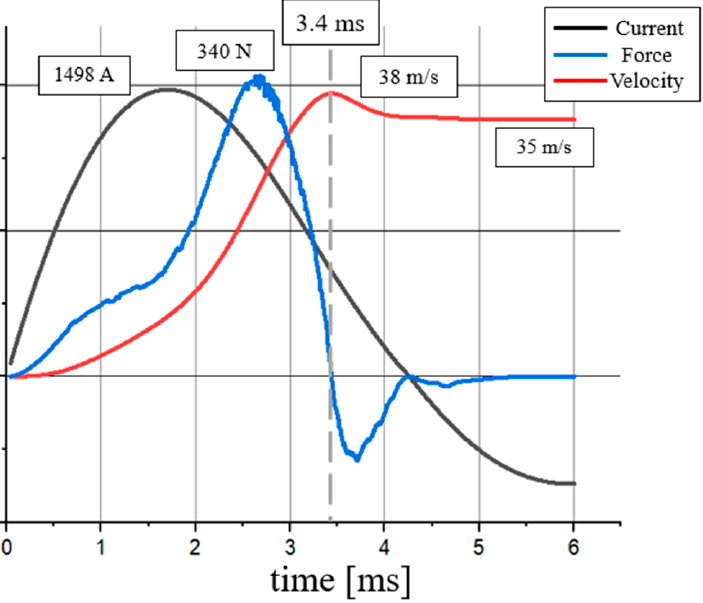
Figure 3. The projectile velocity, electromagnetic force, and supplied current evolutions.